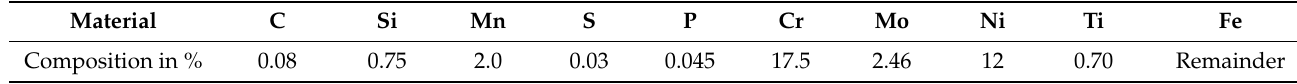
Table 1. Chemical composition of mechtrode AISI316Ti.